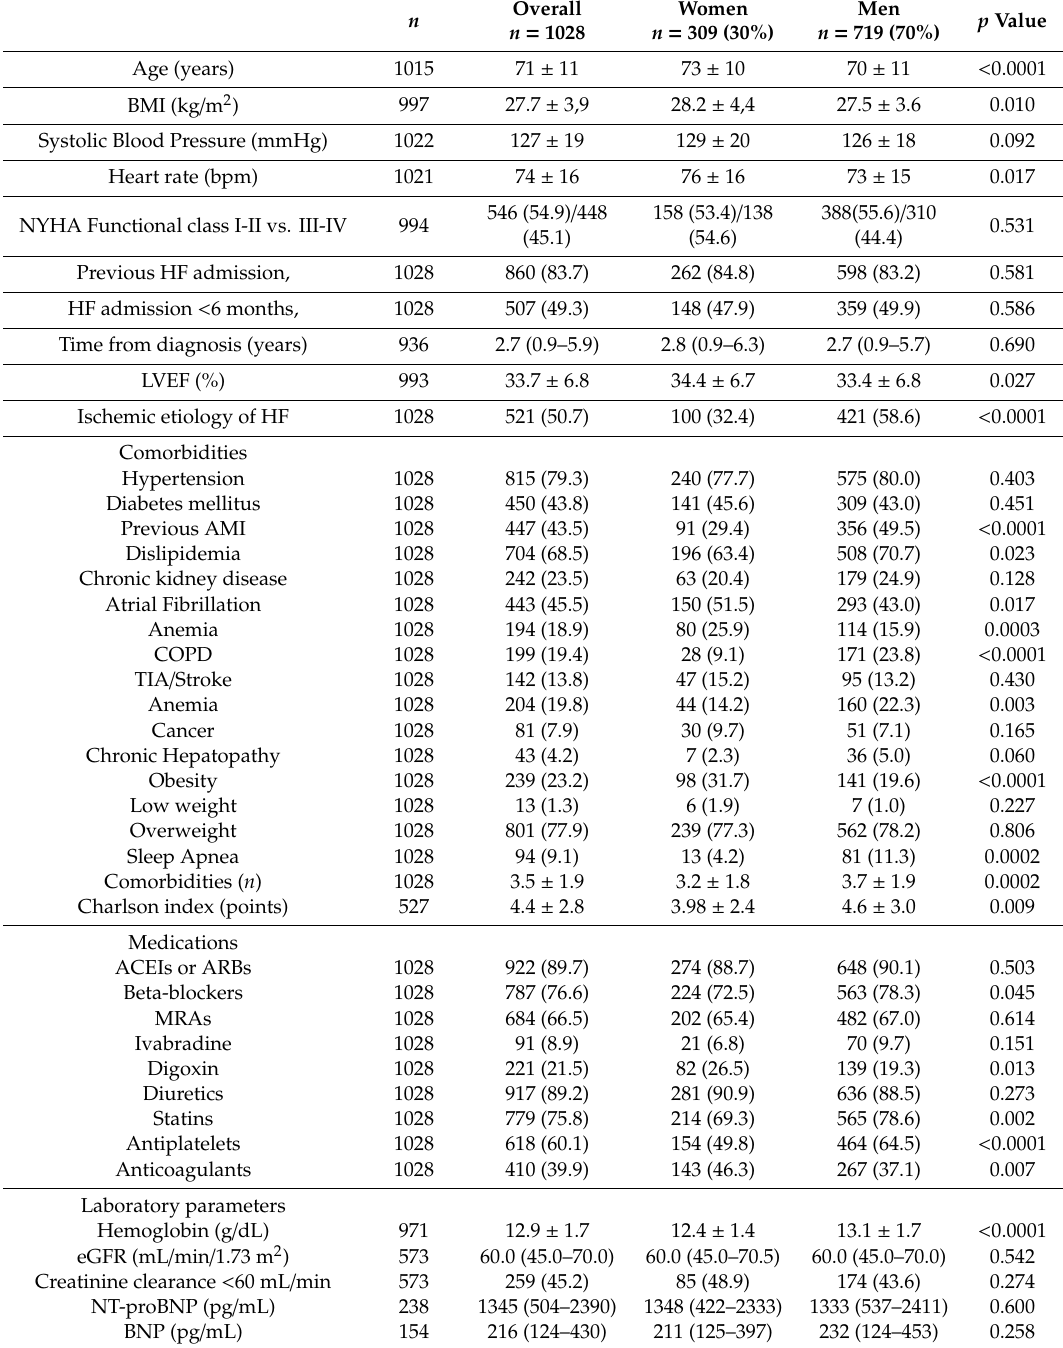
Table 1. Demographic and clinical characteristics of patients included in the study, both overall and according to